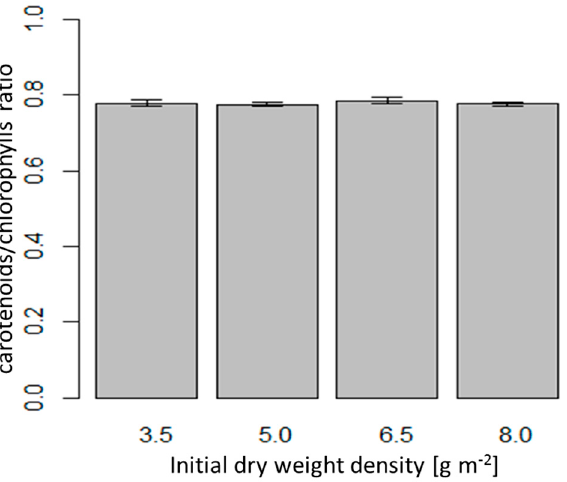
Figure 6. The ratio of carotenoids to chlorophylls in H. pluvialis at different initial biomass densities after 10 days of growth in a PSBR with a low light intensity.